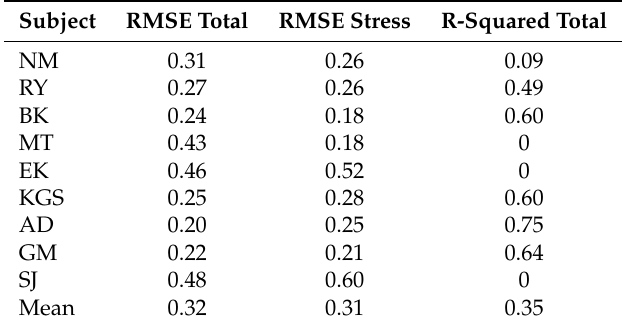
Figure 1. Predicted stress level (blue line) vs. subject estimated continuous target value for stress level (orange line). Personal threshold used to divide outputs as stressed and non-stressed is shown using black horizontal line. Table 5. Subject-wise RMSE and R-Squared using user-independent model and a combination of BVP and ST